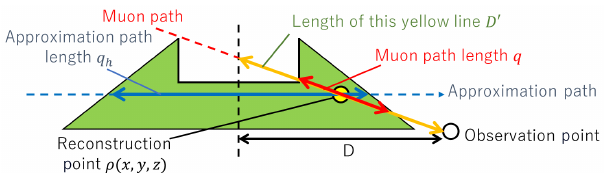
Figure 2. Path length schematic and the approximation difference between the Feldkamp approximation and the path length normal- ization approximation. In the Feldkamp approximation, the approx- imation density length is p (cid:48) = D/D (cid:48) × p . In path length normaliza- tion, the approximation density length is p (cid:48) = q h /q × p